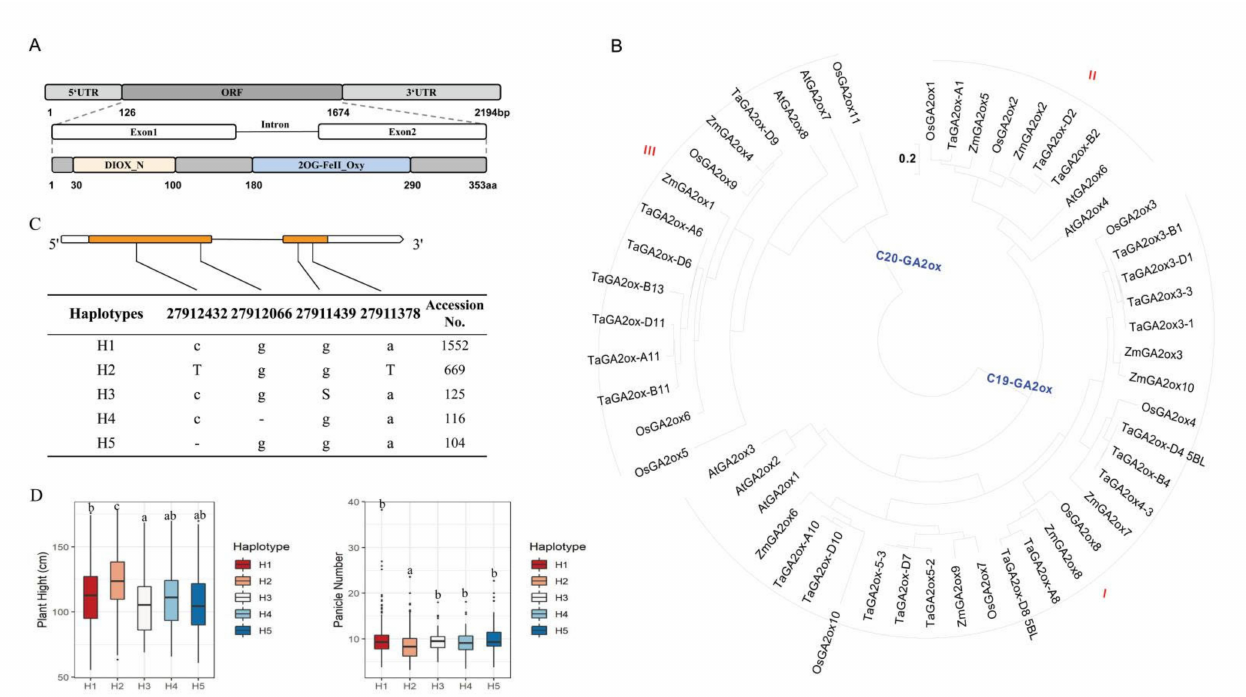
Figure 1. Identification and characterization of OsGA2ox8 . ( A ) Schematic structure of OsGA2ox8 . E1 and E2 represent two exons. ( B ) Phylogenetic relationships among GA2ox amino acid sequences from Triticum aestivum (Ta), Oryza sativa (Os), Arabidopsis thaliana (At), and Zea mays (Zm). Scale bars indicate number of amino acid substitutions per site. ( C ) Major haplotypes of OsGA2ox8 coding sequence based on significant single-nucleotide polymorphisms. ( D ) Plant height and panicle number per plant among different haplotypes. Different letters in ( D ) indicate significant differences ( p < 0.05, one-way ANOVA followed by Tukey’s HSD test) based on data for plant height and panicle number per